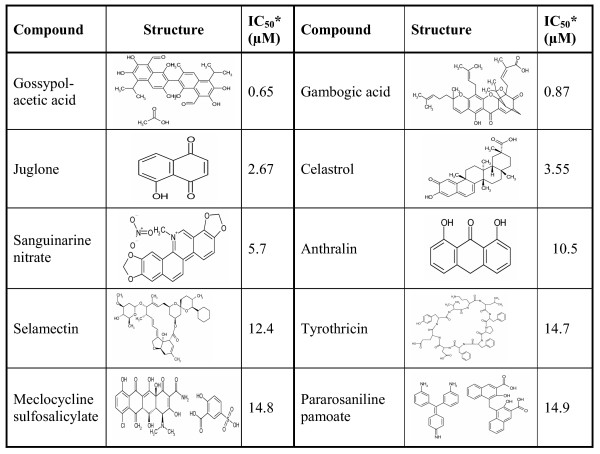
Ten most potent aggregation inhibitors from the NCC library